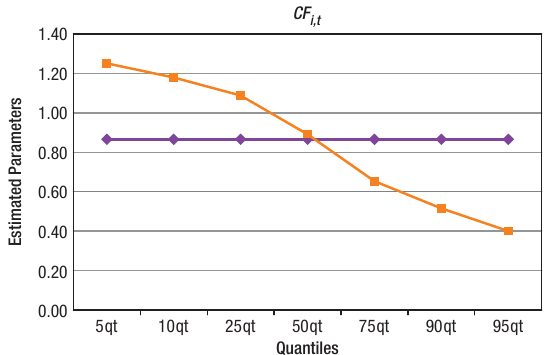
Fig. 2. Estimated parameters of relationship between I Notes: 1. The linear relationship represents OLS regression. 2. The non-linear relationship represents quantile